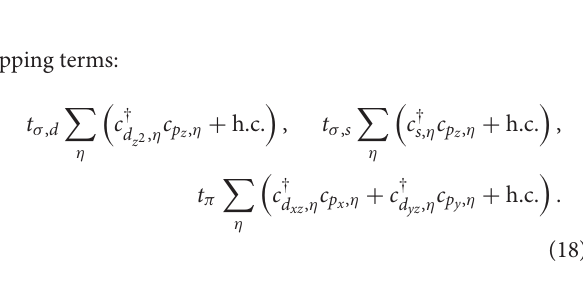
FIGURE 11 | (Left) Parameter values for each fit generated in the MP algorithm, labeled at the step where they are included in the model. A zero value indicates that parameter is not yet added to the model. The sign of J is consistent with Hund’s rules, and the signs of t σ , d and t σ , s are consistent with Se being located in positive z with respect to Fe. (Right) RMS error of each model generated by MP as the algorithm includes parameters. The RMS error of the largest model considered was 0.61